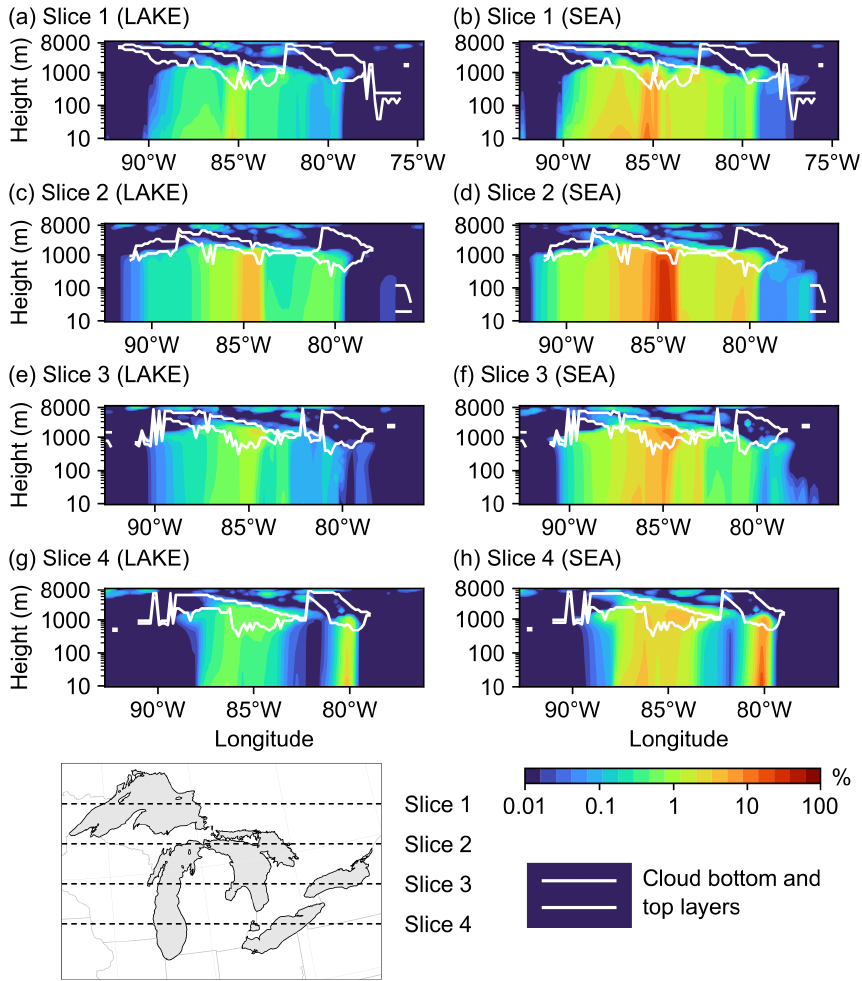
Figure 11. Percent increase in the total vertical aerosol number concentrations in four cross-sections (slices) spanning the Great Lakes basin from north to south in the (a, c, e, g) LAKE and (b, d, f, h) SEA scenarios on 19 November 2016 at 15:00:00UTC. Also shown are the model-estimated cloud bottom and top layers in each